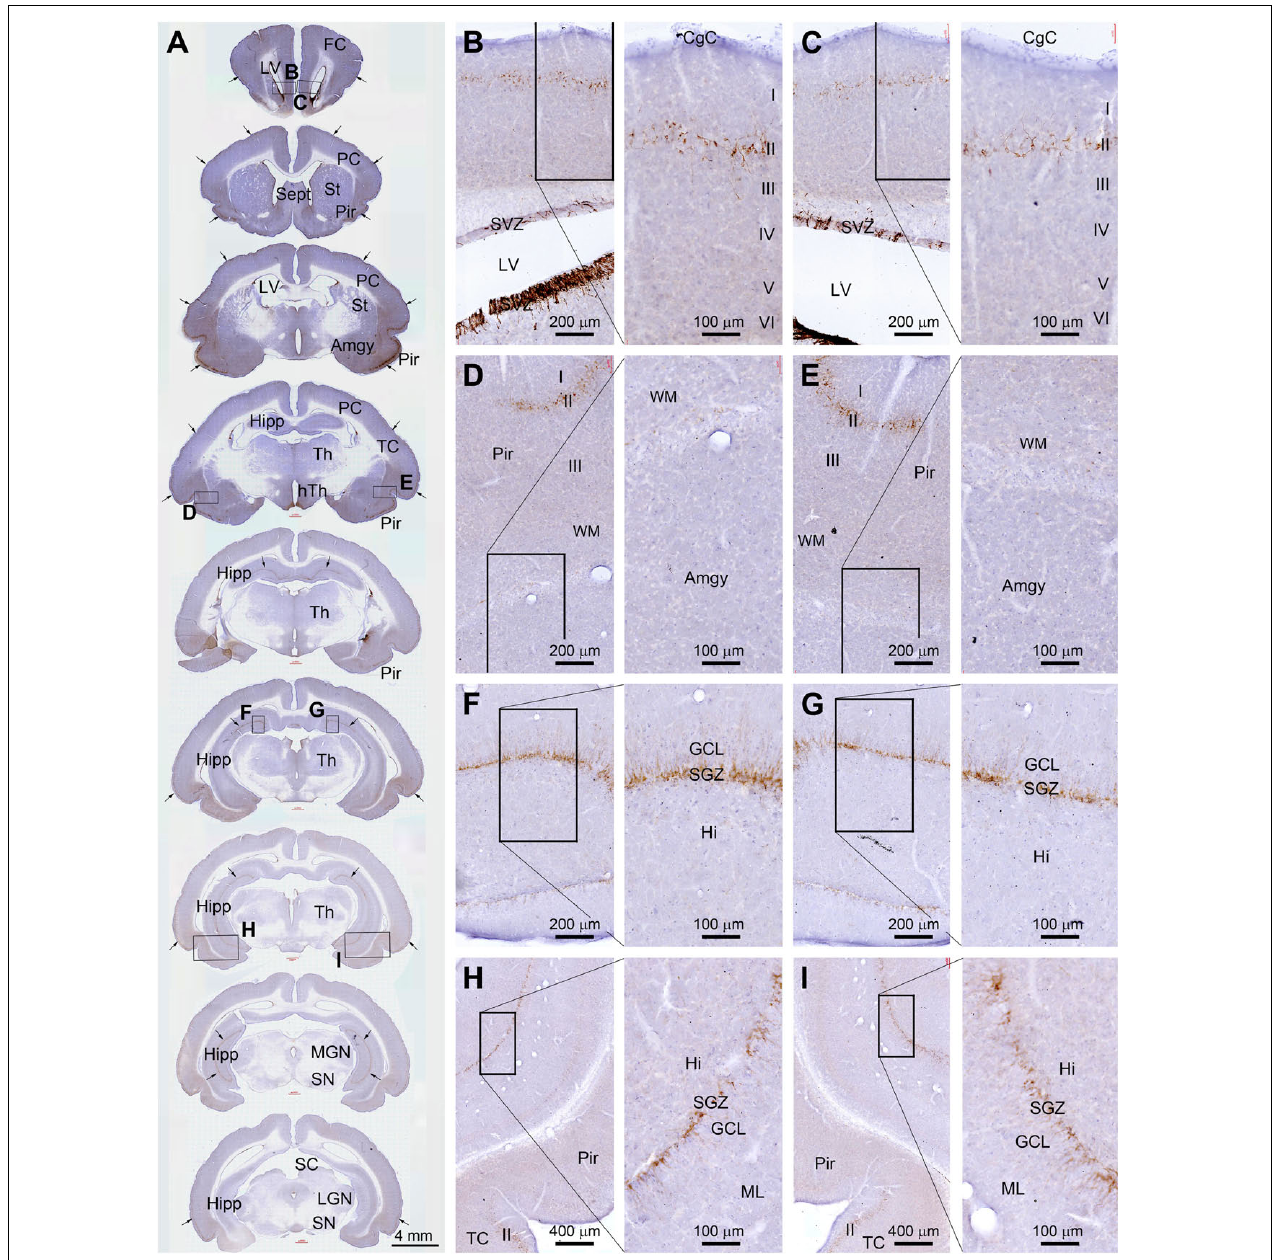
FIGURE 2 | Topographic distribution of doublecortin immunoreactive (+) cells (with hematoxylin counterstain in blue) in normal adult (4-month-old) guinea pig cerebrum. (A) A set of low-magnification images of sections obtained from different rostrocaudal levels, with framed areas in different structures enlarged as the right panels as indicated (B–I) . DCX + cells are located in the subventricular zone (SVZ) surrounding the lateral ventricle (LV) (B,C) , and along the SGZ of the dentate gyrus (DG) (F–I) . They are also distributed along layer II across the piriform cortex as well as neocortical regions (A,D,E,H,I) . The overall amount and distribution of DCX labeling around the LV, in the hippocampal formation, and across the cerebral cortex are present in a symmetric manner between the two hemispheres (as indicated by arrows in A ). FC, frontal cortex; PC, parental cortex; TC, temporal cortex; CgC, cingulate cortex; Sept, septum; St, striatum; Pir, piriform cortex; Amyg, amygdalar complex; Hipp, hippocampal formation; Th, Thalamus; hTh, hypothalamus; MGN, medial geniculate nucleus; LGN, lateral geniculate nucleus; SN, substantia nigra; ML, molecular layer; GCL, granule cell layer; Hi, hilus; I-IV, layers I to VI. Scale bars are as indicated.